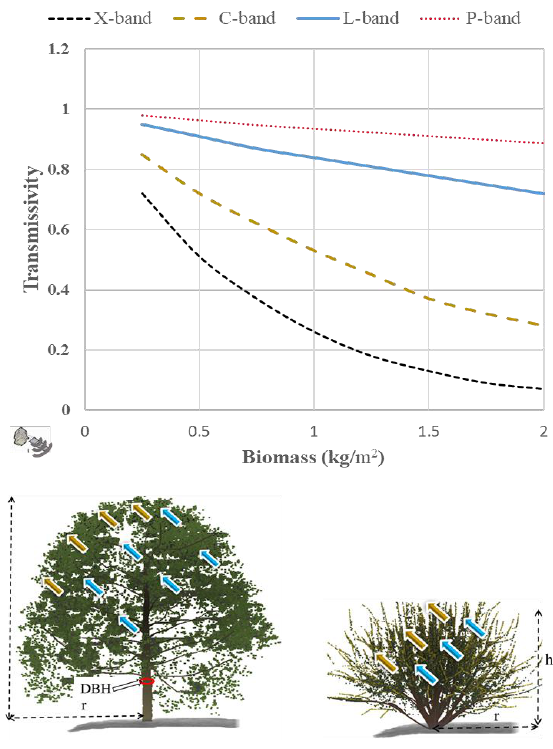
Figure 2 . Canopy transmissivity for sample microwave bands (horizontal co-polarization) corresponding to biomass (Ulaby et al., 1986), and structure parameters for woody plants (bottom left for tree and bottom right for shrub).